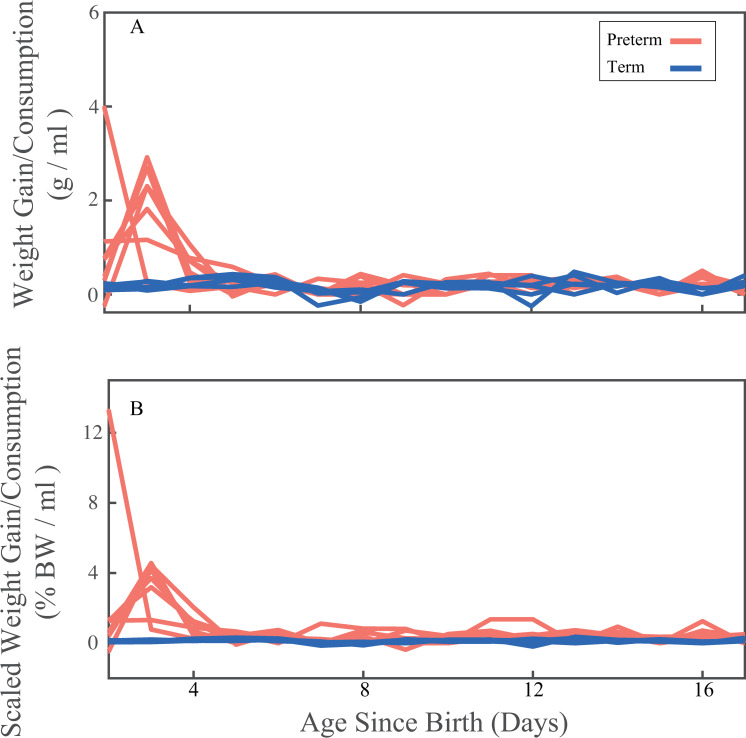
Consumption corrected weight gain trends.Daily weight gain during the postnatal period starting at day one through day 17 expressed as a function of consumption in g/ml (A), and birthweight scaled body weight expressed as a function of consumption expressed body weight as percentage of birthweight / ml consumed (B). Colors indicate birth status for term (blue) and preterm infants (red).